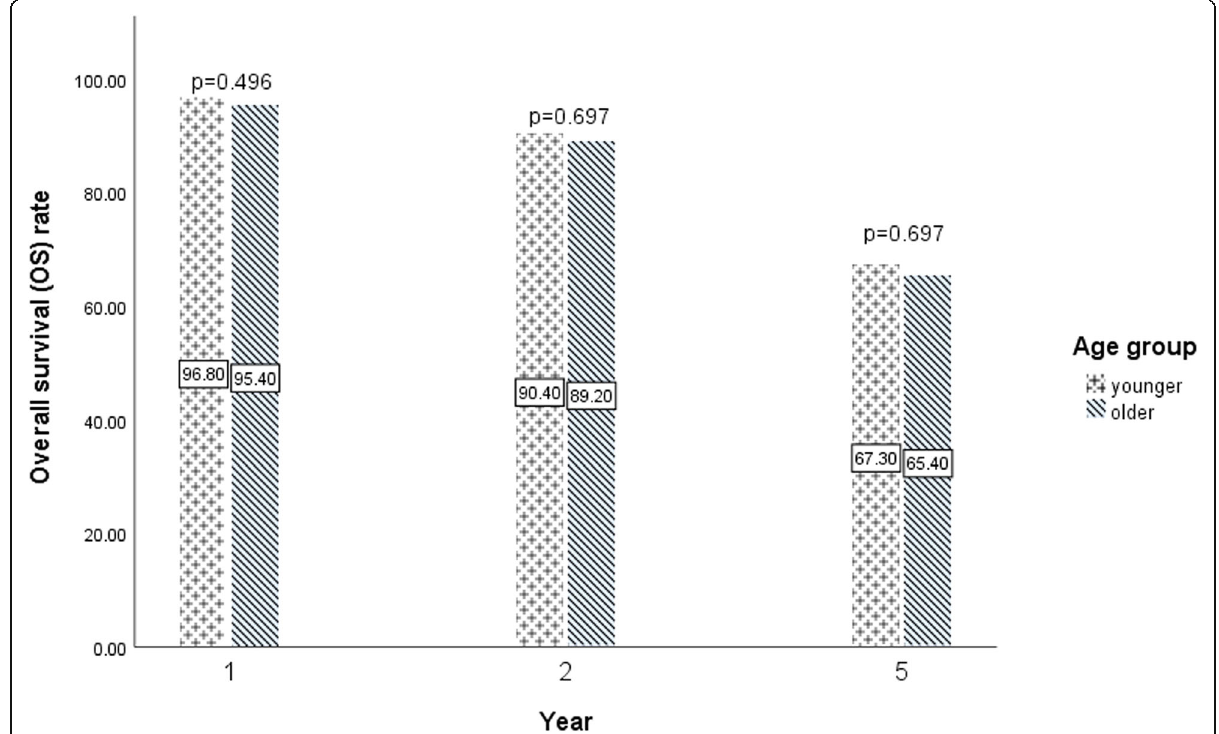
Fig. 1 The 1-, 2-, and 5-year survival rate of patients according to the age